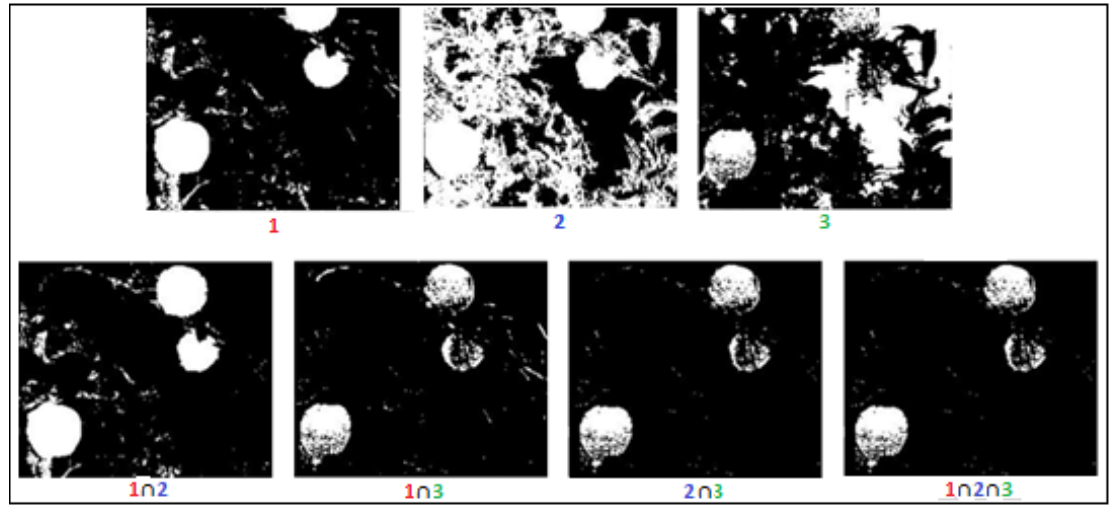
Figure 7. Use of dimension intersection to increase performance.